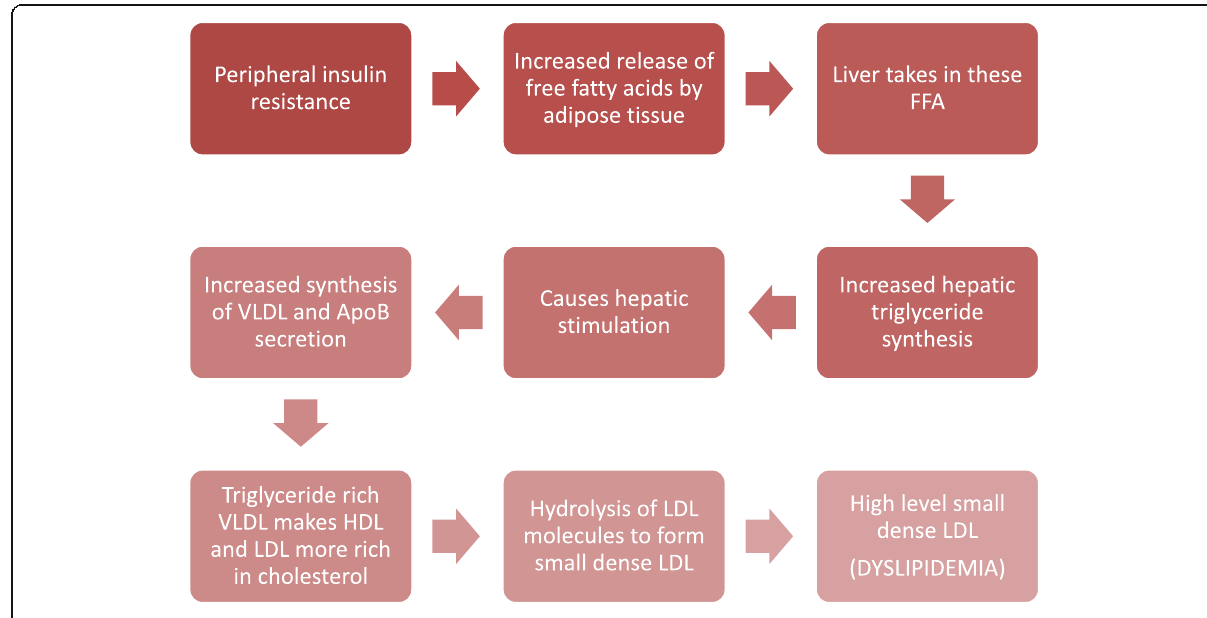
Fig. 3 Mechanism of dyslipidemia in a diabetic patient